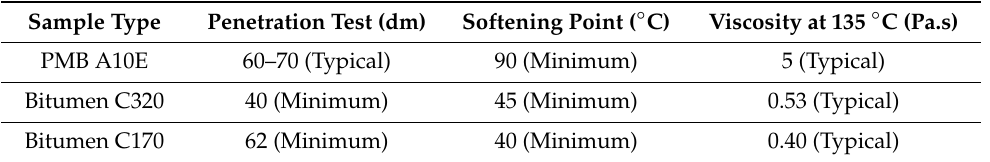
Table 1. Typical properties of bitumen used in this research (adapted from industry approved standards) [42–45].